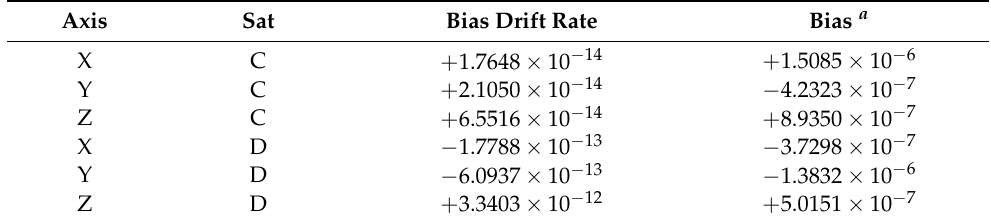
Figure 7. IMU angular rate bias about axis X, Y and Z for GRACE-FO Sat-D on 2 January 2019 in SRF frame. Table 2. The IMU bias and its drift rate for GRACE-FO. Unit of bias is [rad/s], and drift rate is